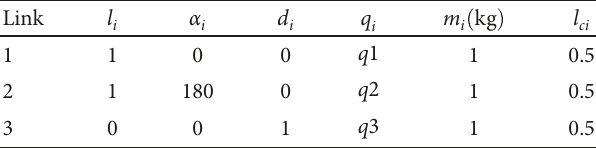
Table 1: Parameters of manipulator in the